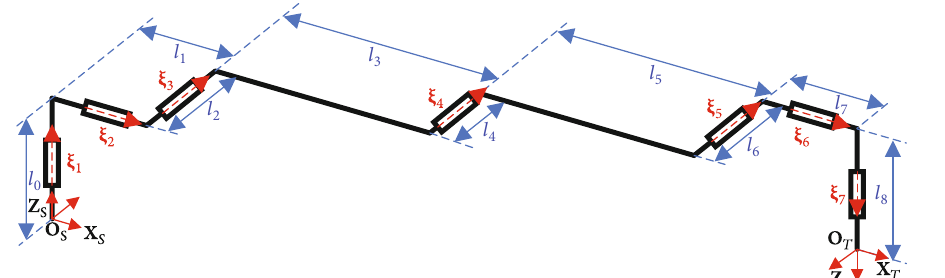
Figure 3: The kinematics model of an SSRMS-type